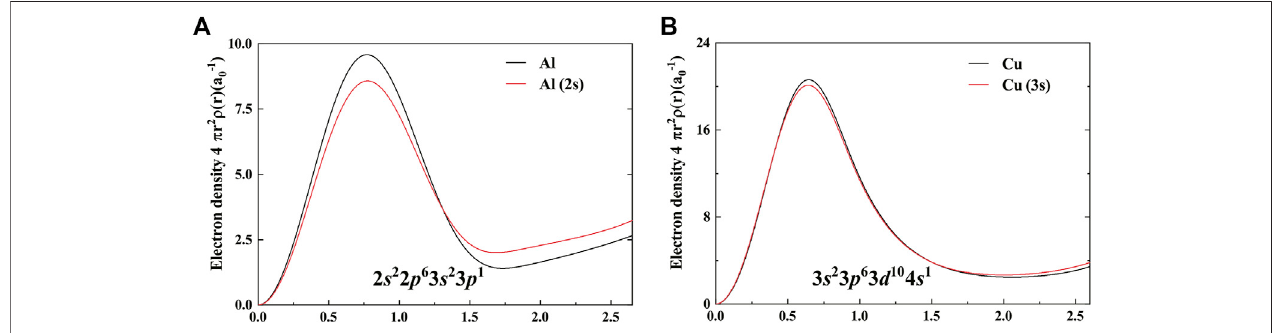
FIGURE 3 | Calculated phonon dispersion of Al and Cu placed in their perfect lattice structure at room temperature with variable method and variable number of holes in their inner shell. Experimental measurements are plotted as purple dots for comparison [72, 73]; the green triangles correspond to the DFPT method, and the blacklinescorrespondtothe fi nitedisplacementmethod. (A) Al:theorangedash-dottedlinesrepresenttheatomswith fi veelectronsremovedfromthe2sorbital. (B) Cu: theorangedash-dottedlinesrepresent theatomswiththreeelectronsremovedfromthe3sorbital. (C) Al:thereddashedlinesandbluedottedlinescorrespondto theatomswithaholeandtwoholesinthe2sorbital,respectively. (D) Cu:thereddashedlinesandbluedottedlinescorrespondtotheatomswithaholeandtwoholesin the 3s orbital, respectively.